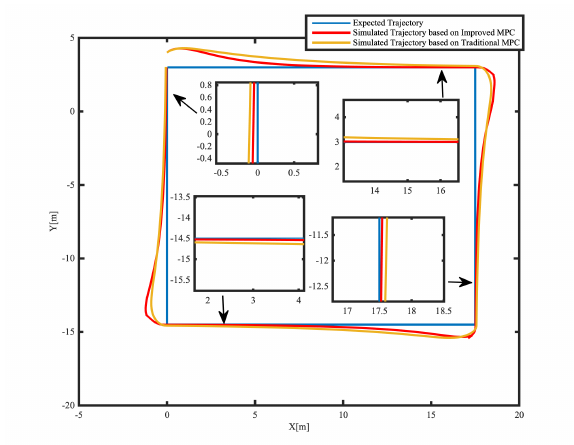
Figure 12. The comparison result in square tracking.